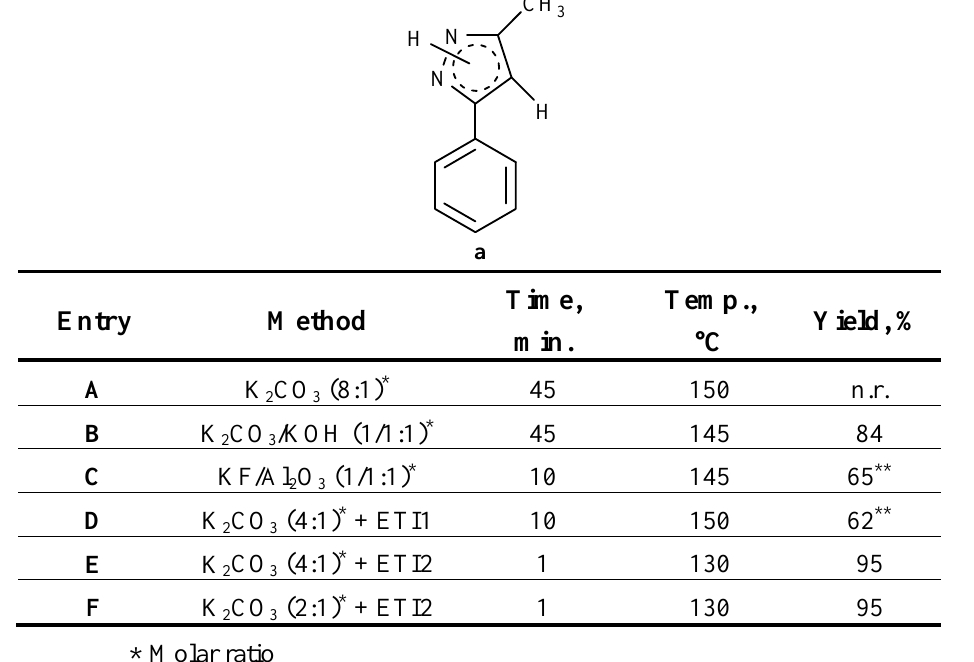
Table 2. Operative conditions and relative yields for the synthesis of product a from